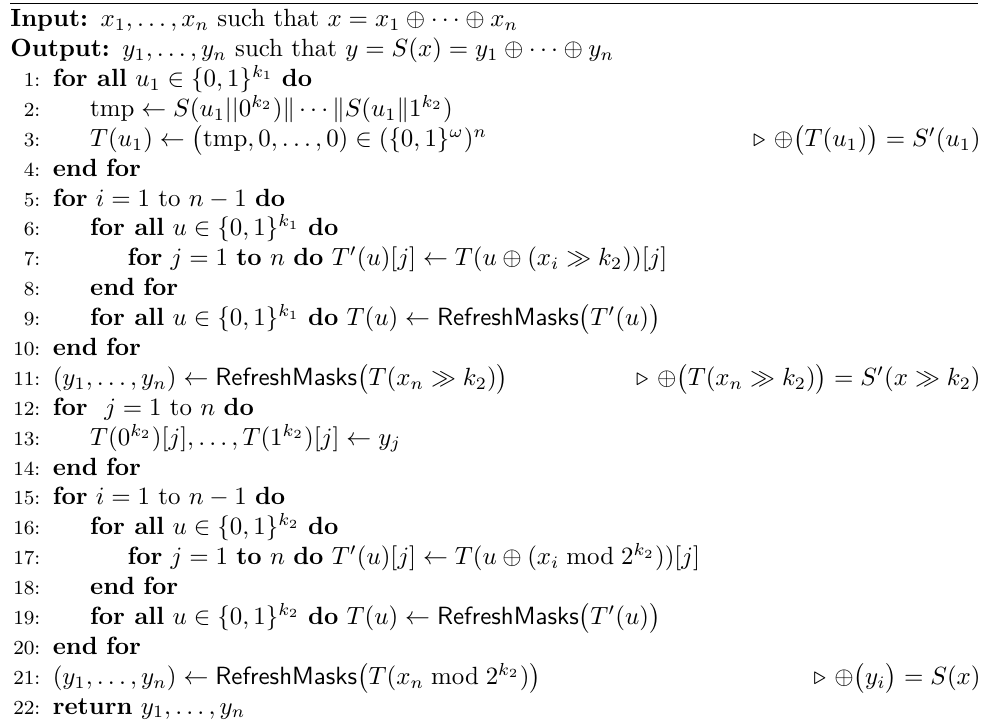
Algorithm 7 Evaluation of y = S ( x ) with registers of size ω = 2 k 2 · k 0